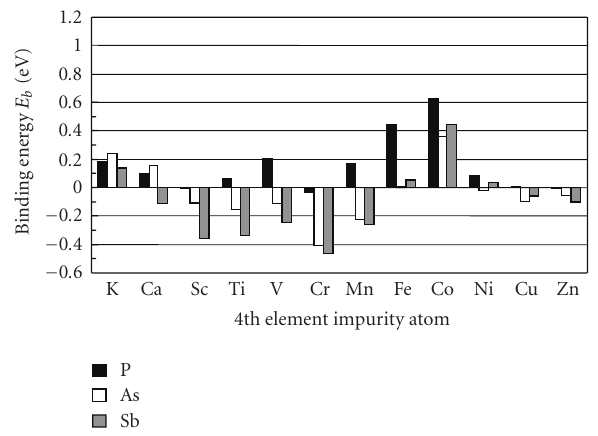
Figure 3: Calculated binding energy E b of n -type dopants to 4th element impurity atoms.